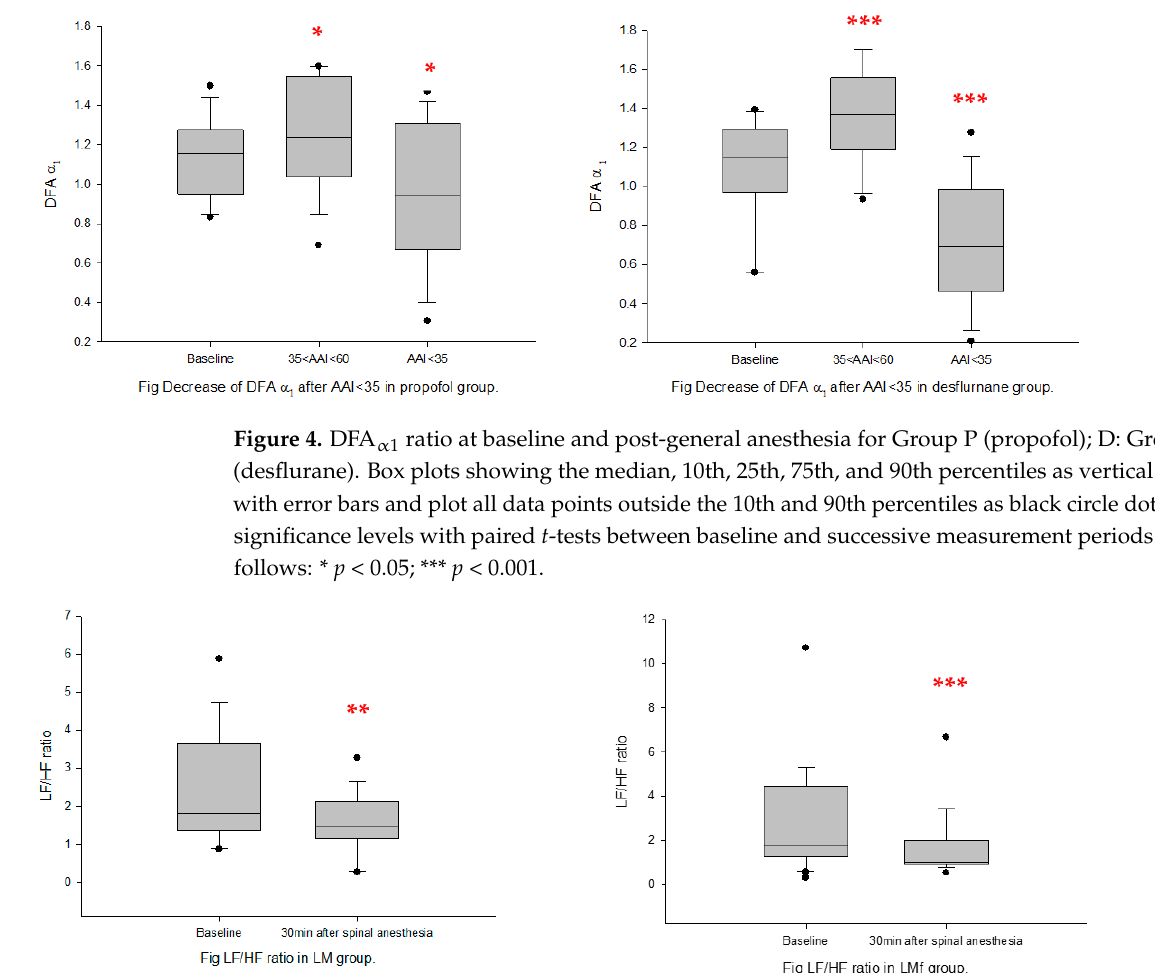
9 of 17 Figure 3. LF/HF ratio at baseline and post-general anesthesia for Group P (propofol); Group D (desflurane). Box plots show the median, 10th, 25th, 75th, and 90th percentiles as vertical boxes with